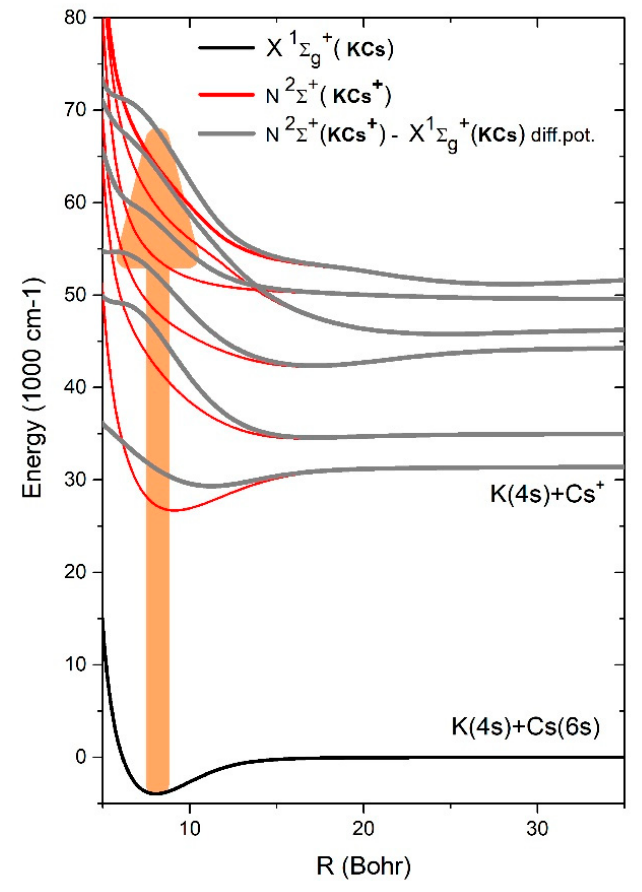
Figure 3. Potential curves of the ground state KCs molecule with six potential curves of KCs + molecule [17,18] of 2 Σ + symmetry (red lines) together with the relevant difference potentials N 2 Σ + ( KCs + ) − X 1 Σ + ( KCs ) (bold gray lines).